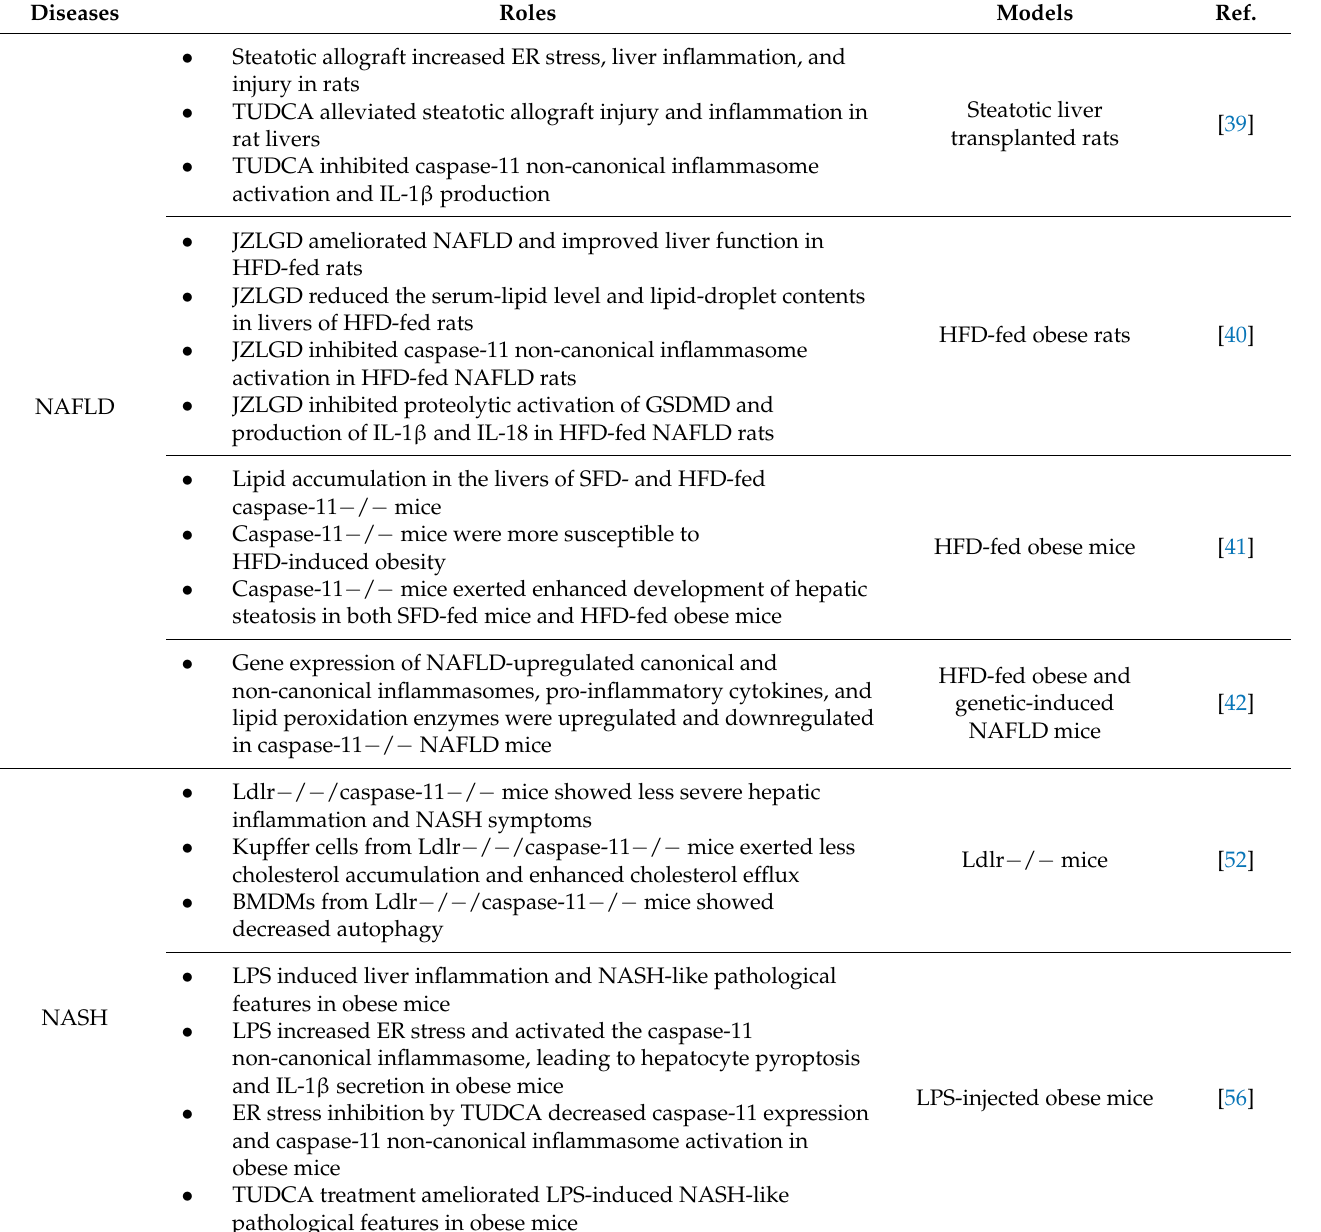
Table 1. Regulatory roles of the caspase-11 non-canonical inflammasome in inflammatory liver diseases. Roles Models